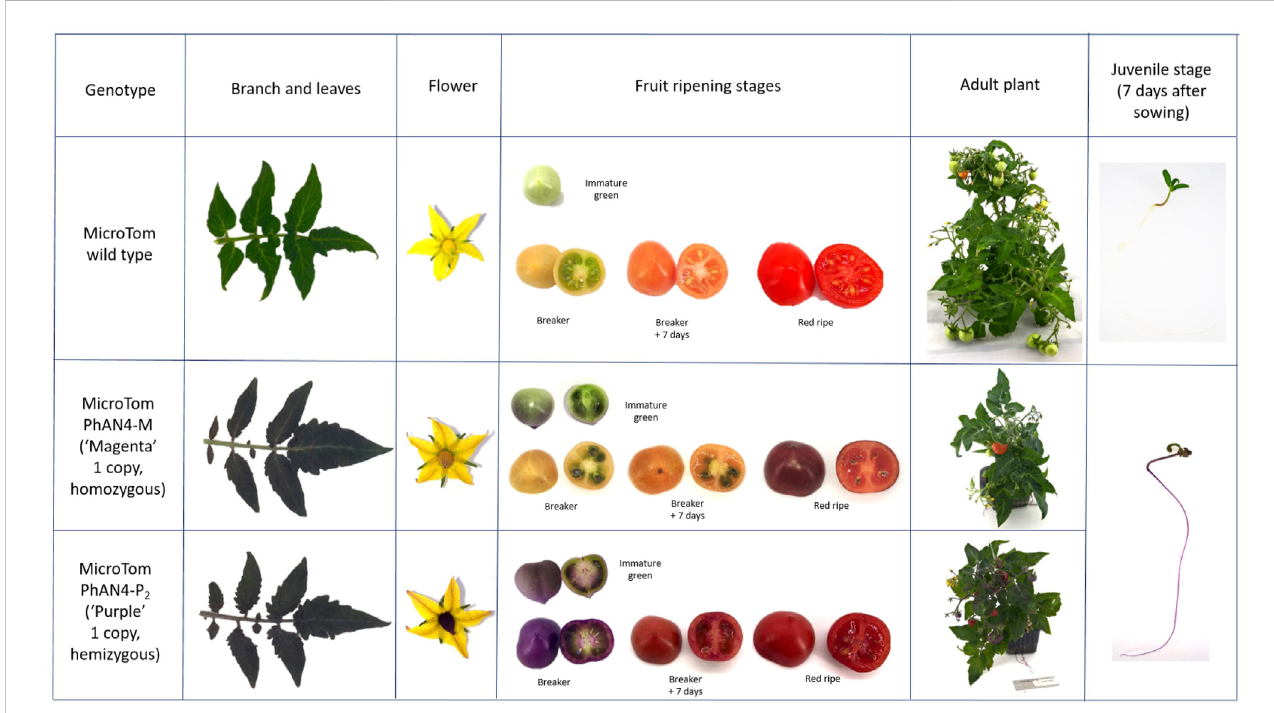
FIGURE 4 Genotype-speci fi cphenotypes ofT 3 generationMicroTom expressing PhAN4 underthecontrol oftheCaMV35S promoter.Phenotypic analysisofwild-